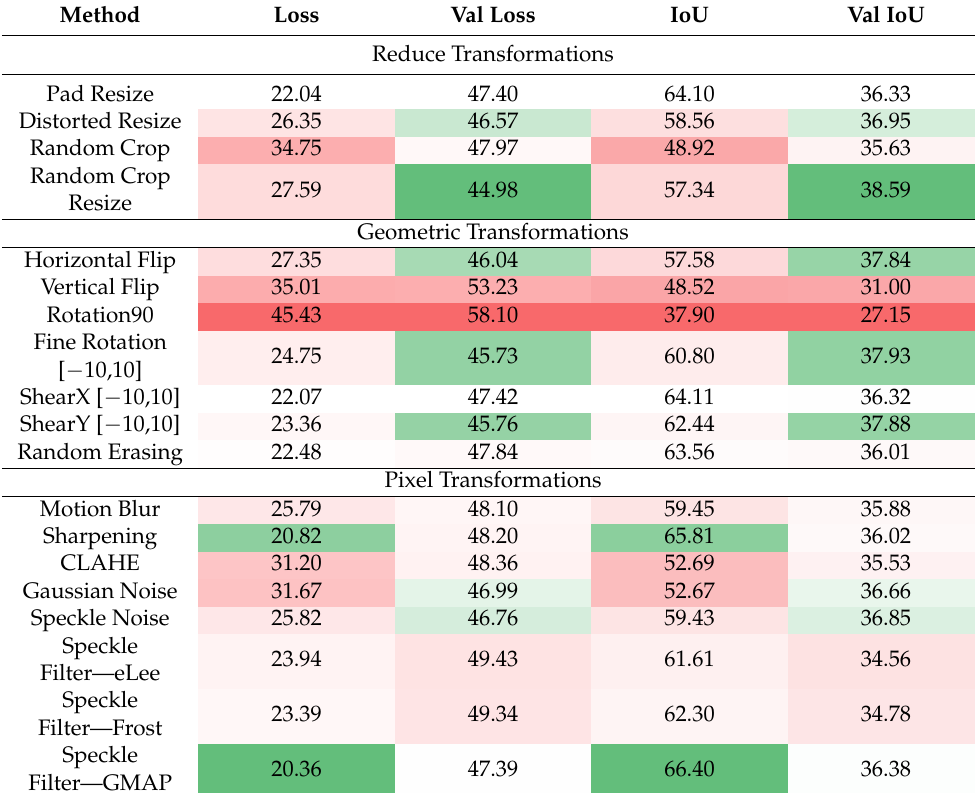
Table 2. Results of Ablation study. All scores are in percentage units. For loss, the lower is better. For IoU, the higher the better. Scores are color-coded in comparison to Pad Resize, where green color projects positive gain while red projects negative